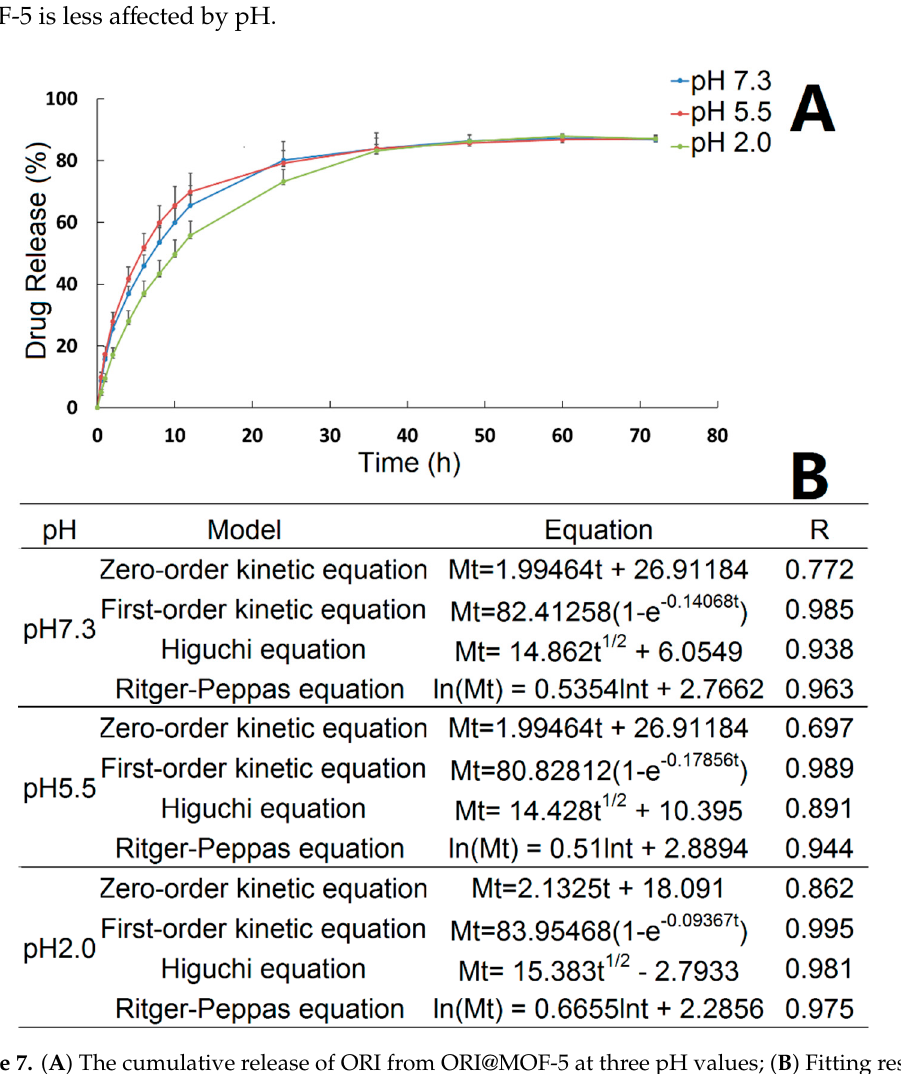
Figure 7. ( A ) The cumulative release of ORI from ORI@MOF-5 at three pH values; ( B ) Fitting results of equation.